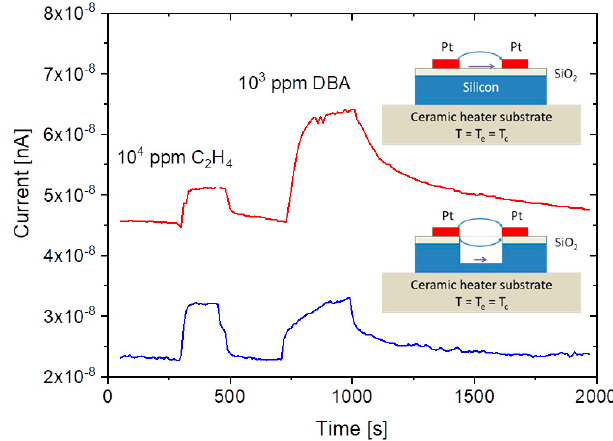
Figure 12. Gas response of an edge-to-edge SI detector configuration towards 10 4 ppm of ethene and 10 3 ppm dibutyl-amine (DBA) admixed to synthetic air. Top panel: Conventional edge-to edge device; bottom device with additional trench saw cut to suppress parasitic surface currents.